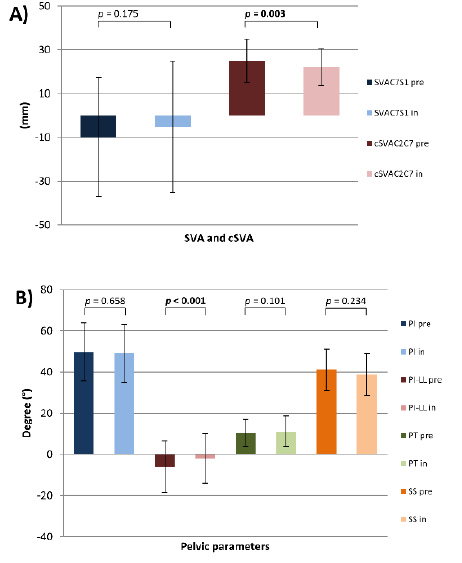
Figure 4. Sagittal plane parameters of cervical ( A ), thoracic ( B ) and lumbar ( C ) spine for all patients (pre- and in-brace); p = statistical significance, p < 0.05.